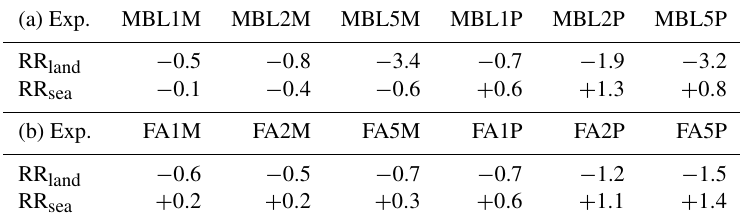
Figure 7. Distribution of the 6h accumulated precipitation simulated by (a) MBL1M, (b) MBL2M, (c) MBL5M, (d) MBL1P, (e) MBL2P, and (f) MBL5P at 18:00UTC on 14 October 2012. The black contour line shows the coast of southern France. The ellipsoid in panels (a) – (c) indicates the area with less precipitation than CNTL, while the ellipsoid in panels (d) – (e) shows the shifted precipitation area to the offshore region. Table 2. Deviation of domain-averaged 6h total accumulated precipitation amount over land (RR land ) and over sea (RR sea ) for the MBL and FA experiments with respect to the CNTL (RR land of 14.2mm, RR sea of 1.5mm) within the fixed area (40.5–45 ◦ N, 3.5–9 ◦ E) from 12:00UTC on 14 October 2012. (a) Exp. MBL1M